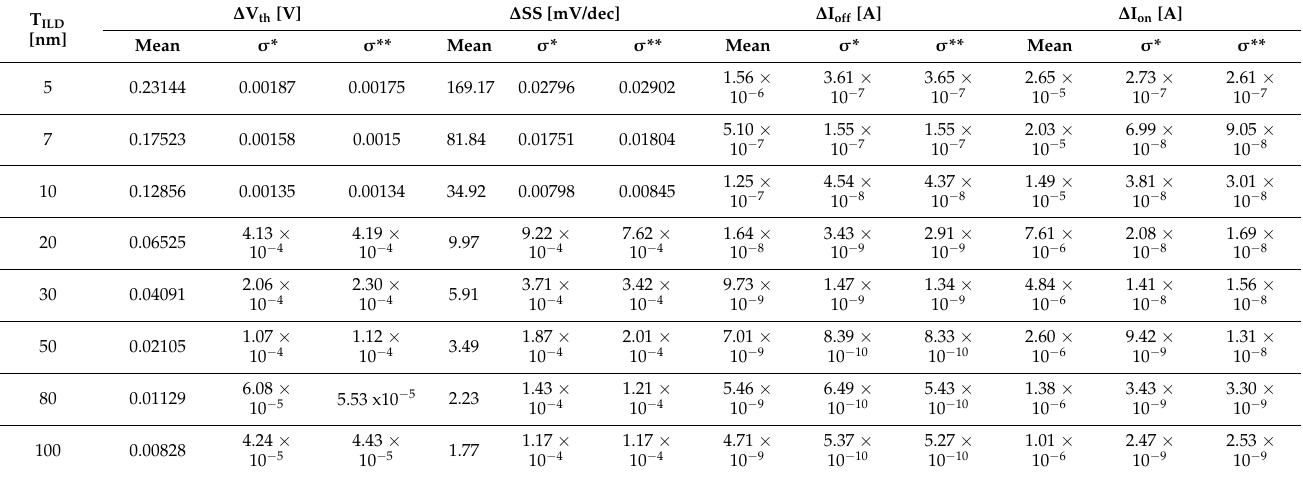
standard deviation of Δ SS, calculated from (2)